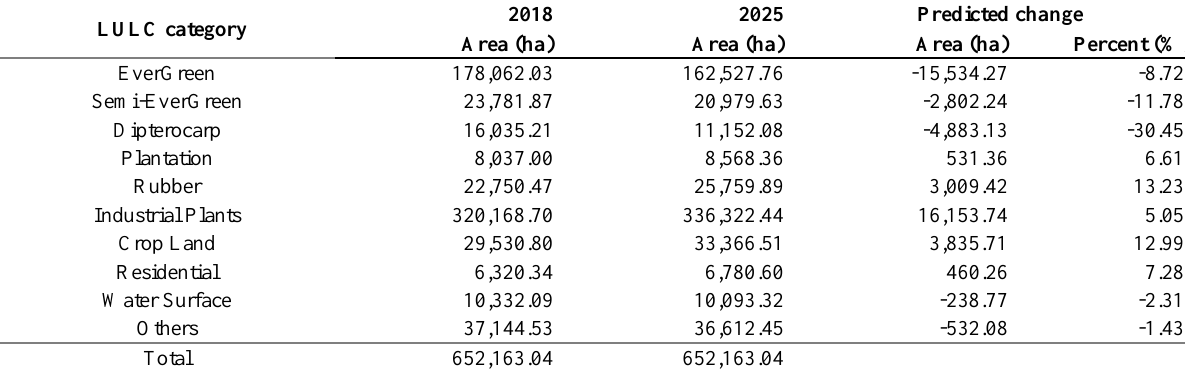
Table 4. Predicting area change of LULC in the period of 2018-2025